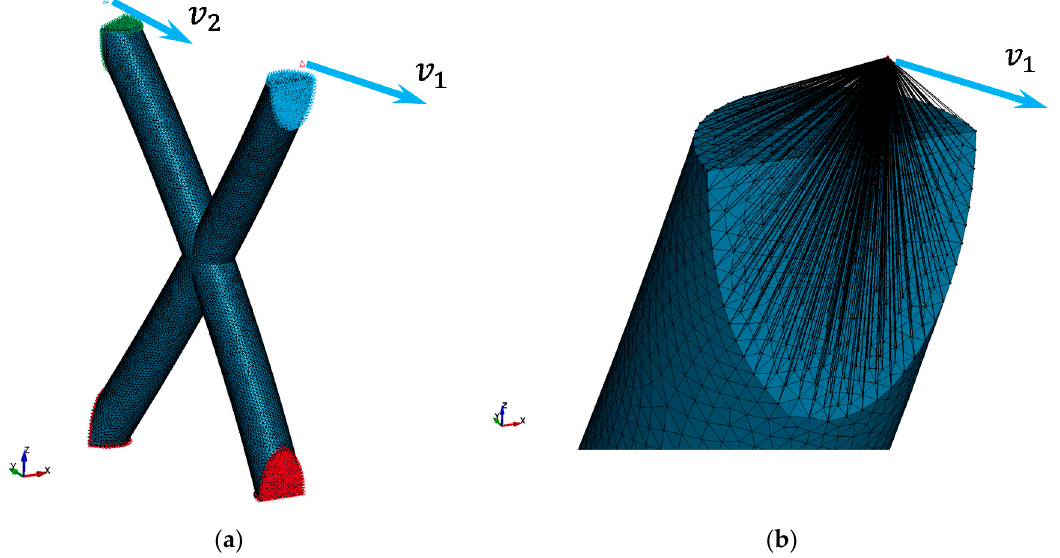
Figure 14. Geometry and boundary conditions of the unit cell model, with load directions v 1 and v 2 at additional massless nodes above upper ends and clamped lower ends of the unit cell ( a ). Enlarged detail view of one load node with constraints on the upper cutting planes ( b ).